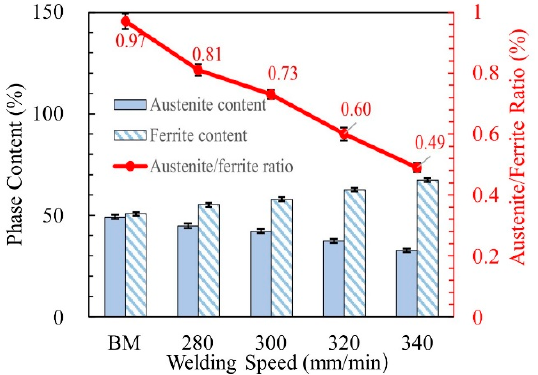
Figure 6. Phase content and austenite/ferrite ratio in the BM and WMZ under different welding speeds.